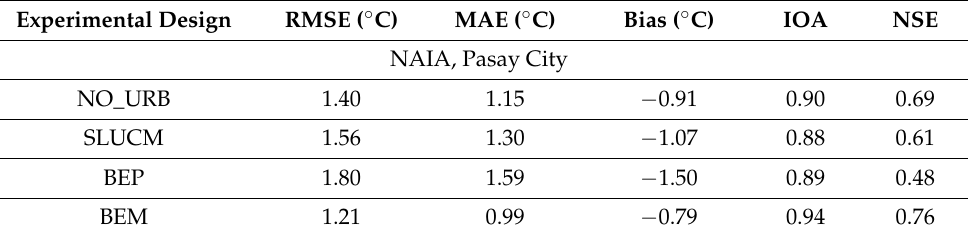
Table 4. Statistical performance result of no urban ( NO_URB ), single layer urban canopy model ( SLUCM ), building effect parameterization ( BEP ), and building energy model ( BEM ) over daily averaged air temperature for the three location